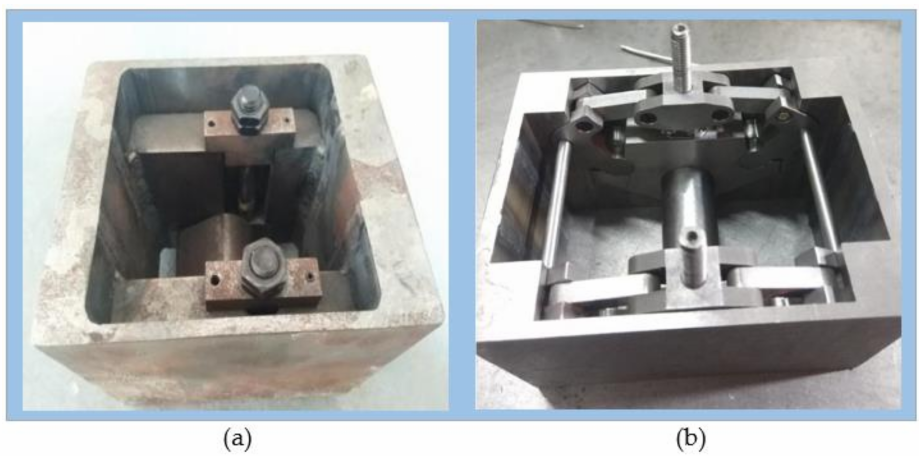
Figure 10. Scale sample. ( a ) The TCS; ( b ) The novel TBM